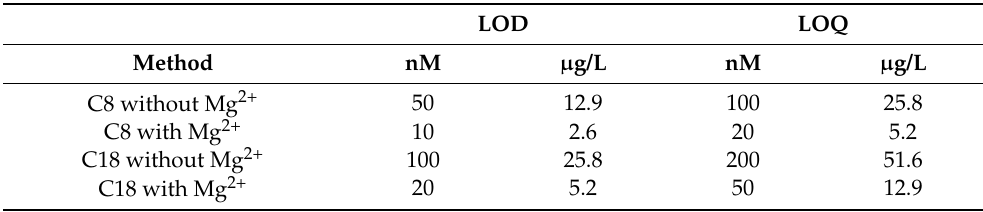
Figure 8. Representative chromatograms of AOH without or with MgCl 2 (50 mM) in the eluent ( A ). Linearity of the concentration-AUC curves regarding the C8 ( B ) and C18 ( C ) methods. Table 3. LOD and LOQ values of the HPLC-FLD methods applied, without and with 50 mM MgCl 2 in the